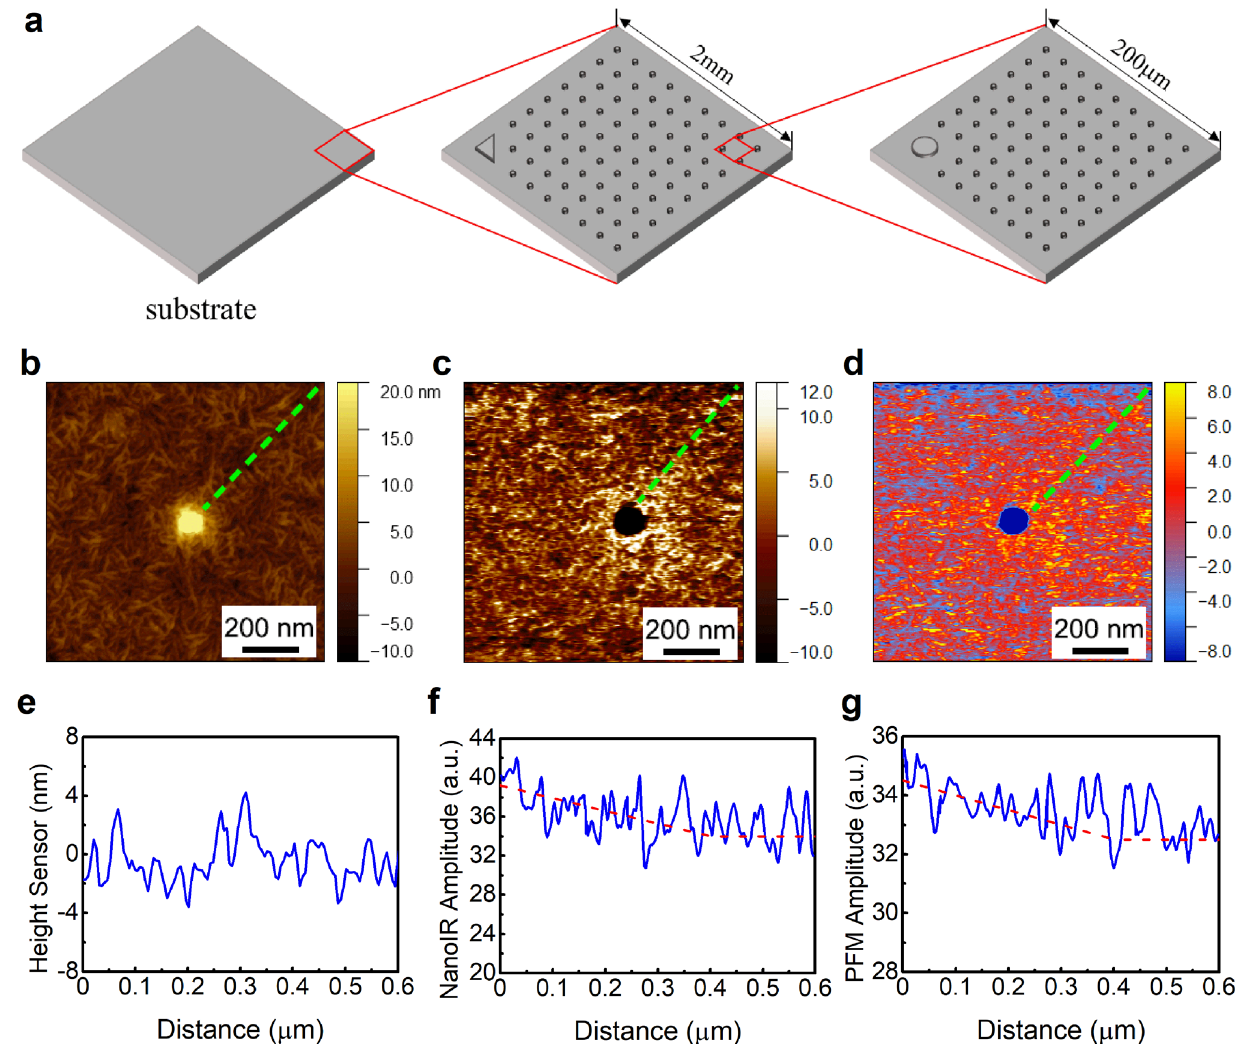
Fig. 1 a Schematic of substrate structure. b The topography, c PFM mapping and d Nano-IR mapping at 1288 cm −1 of P(VDF-TrFE)/BTO nanocomposites. e Profile of b at the dashed line. f Profile of c at the dashed line. g Profile of d at the dashed